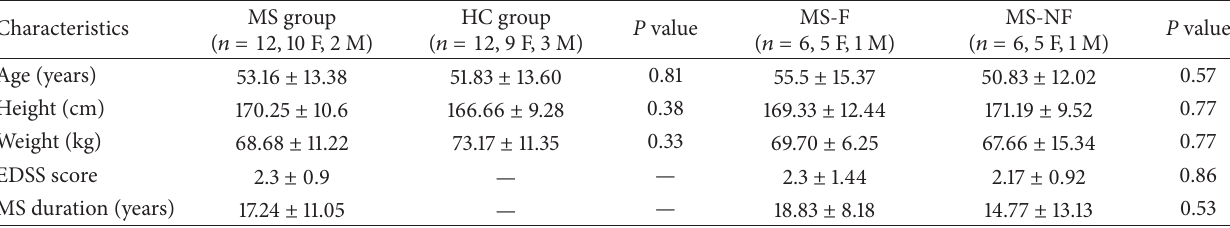
Table 1: Demographics for the MS and HC